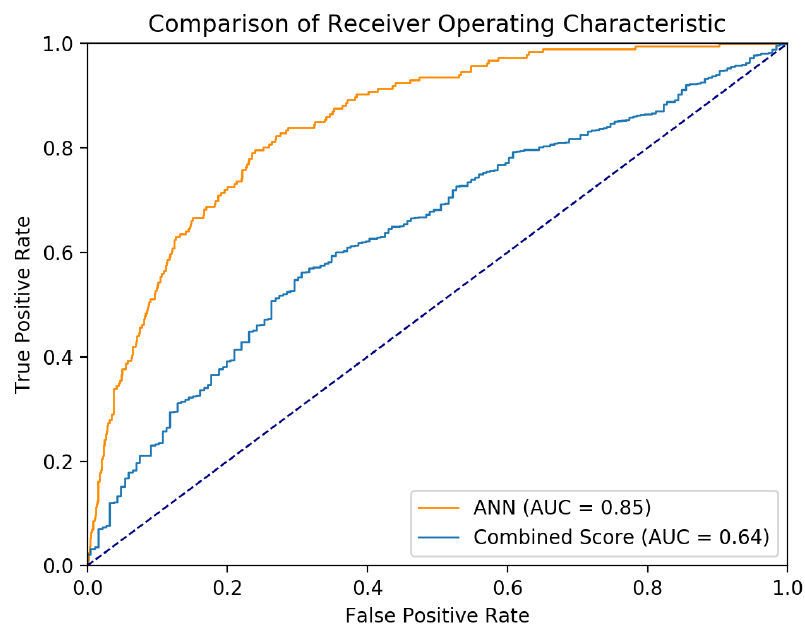
Figure 2. Receiver operating characteristic curve of artificial neural network (ANN) and the composite score created from significant variables.